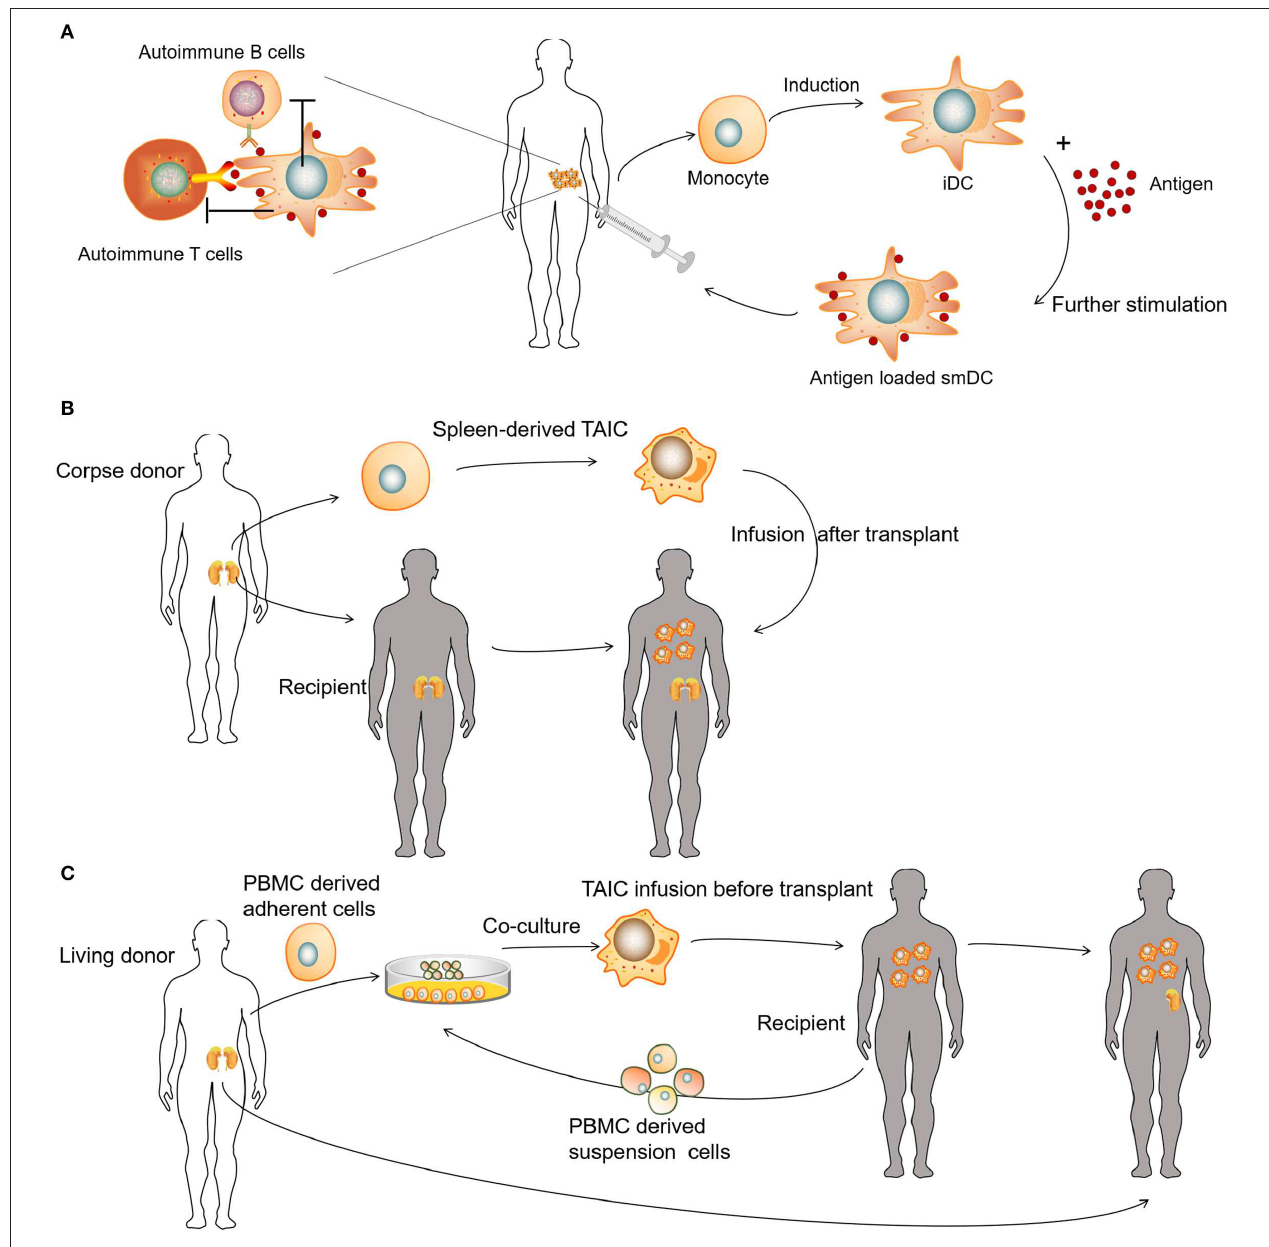
FIGURE 4 | Clinical uses of various tolerogenic antigen-presenting cell (tolAPC) methods. (A) Patients receive autoantigen-loaded tolDCs. (B) Patients receive kidney transplants and corpse donor spleen-derived transplant acceptance-inducing cell (TAIC) treatment. (C) Patients receive living donor PBMC-derived TAICs before kidney